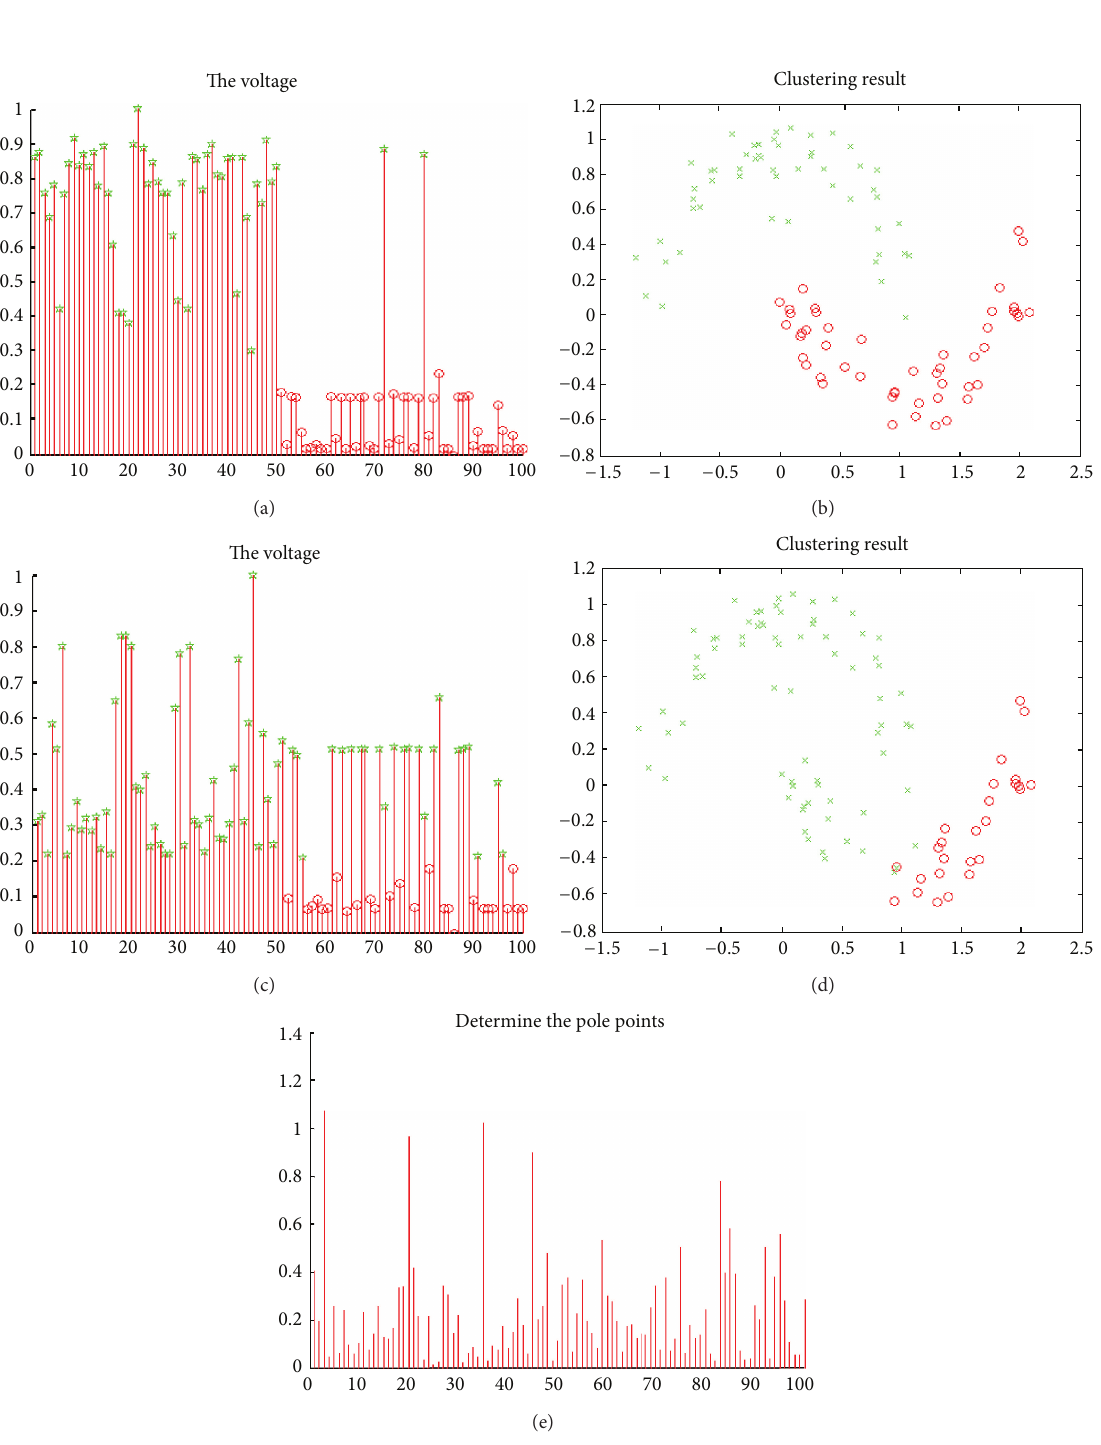
Figure1:ClusteringresultsoftheWu-Hubermanalgorithmforthetwo-moonpatternwithdifferentpolepointselections.(a)Thedistribution of the voltage values when 22nd and 86th points have been chosen as the poles. (b) The clustering results corresponding with (a). (c) The distribution of voltage values when the 45th and 86th points have been chosen as the poles under the same dataset, algorithm, and parameters with (a). (d) The clustering results corresponding to (c). (e) The graph of determining the pole points. The 𝑥 -axis is the data point number, and the 𝑦 -axis is the value of sparse rate 𝛿